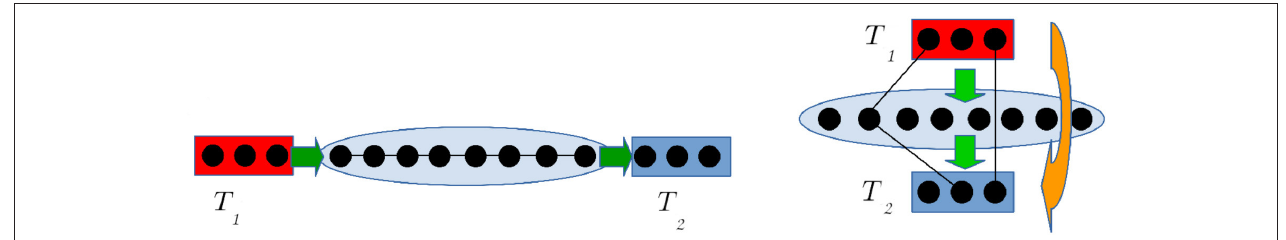
FIGURE 2 | Pictorial representations of heat transfer processes for long-range interacting chains, in the limiting cases of α contact with thermal reservoirs are enclosed in rectangular boxes while ones in the bulk are enclosed in the ellipse. The relevant transport channels are represented by black lines. Adapted with permission from Di Cintio et al. [74]. Copyright © 2019 American Physical Society.